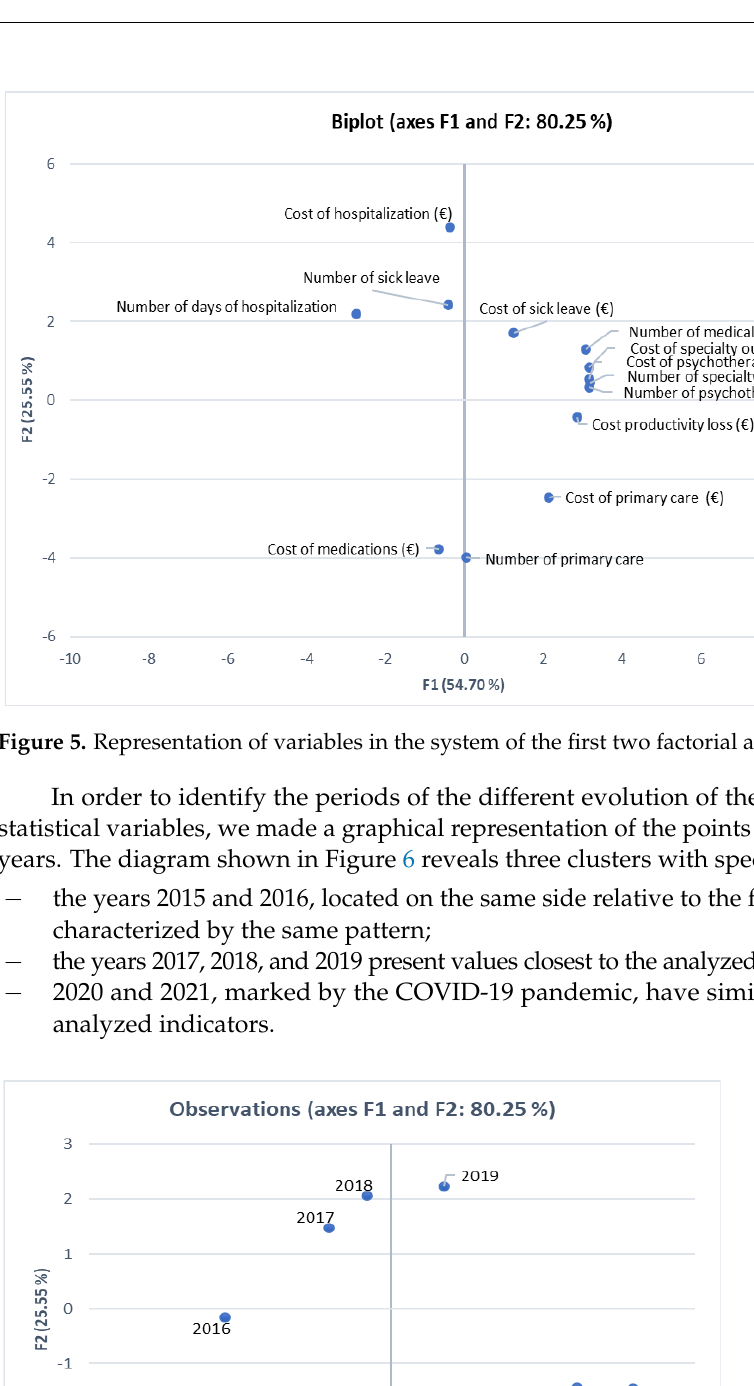
8 of 14 formation of factor axes (principal components) which represent a linear combination of variables that are correlated with each other. These axes make it possible to explain the similarities and differences between the statistical units in terms of all the variables con- sidered. Since the first two factorial axes cumulate 80% of the total variance (Table 2), our analysis will relate only to them, as shown in Figure 5. The first factorial axis highlights a strong correlation between the variables: number of medical prescriptions consultations, number of prescriptions, outpatient cost, cost of psychotherapy, number of psychother- apy consultations, number of outpatient consultations, and cost of general practice. These variables form a cluster. All these variables are far from the number of consultations dur- ing hospitalization, with which they are in a reverse connection. Table 2. Total variance explained.